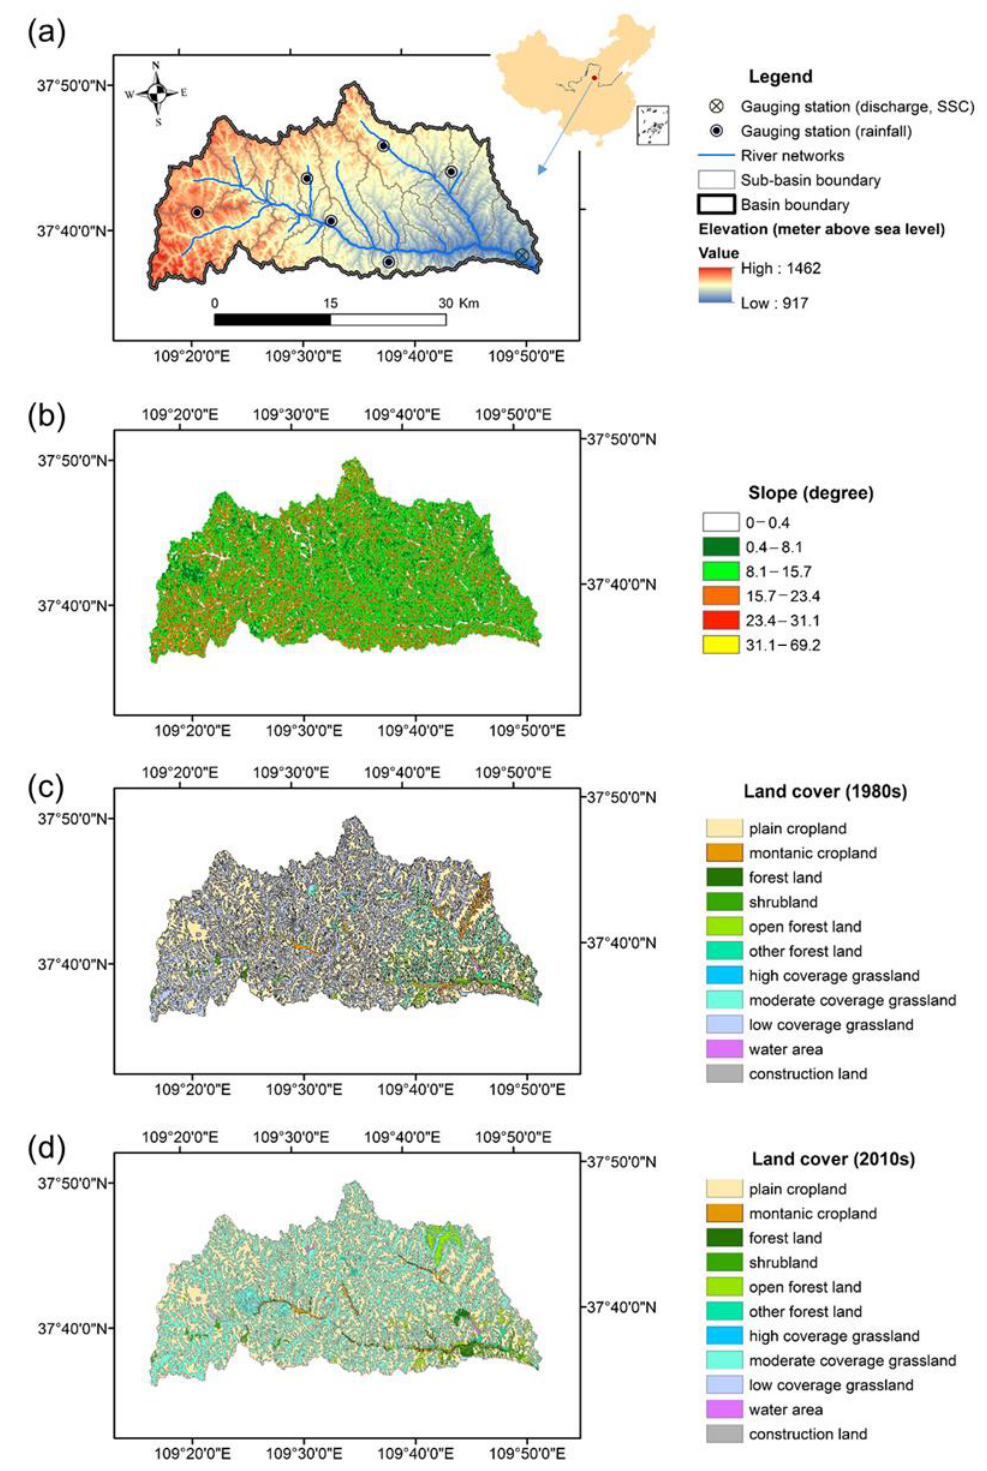
Figure 1. Maps of the studied Xiaolihe watershed including ( a ) the location in the middle reach of the Yellow River, DEM and distributions of gauging stations; ( b ) slope; ( c ) land use in the 1980s; and ( d ) land use in the 2010s.